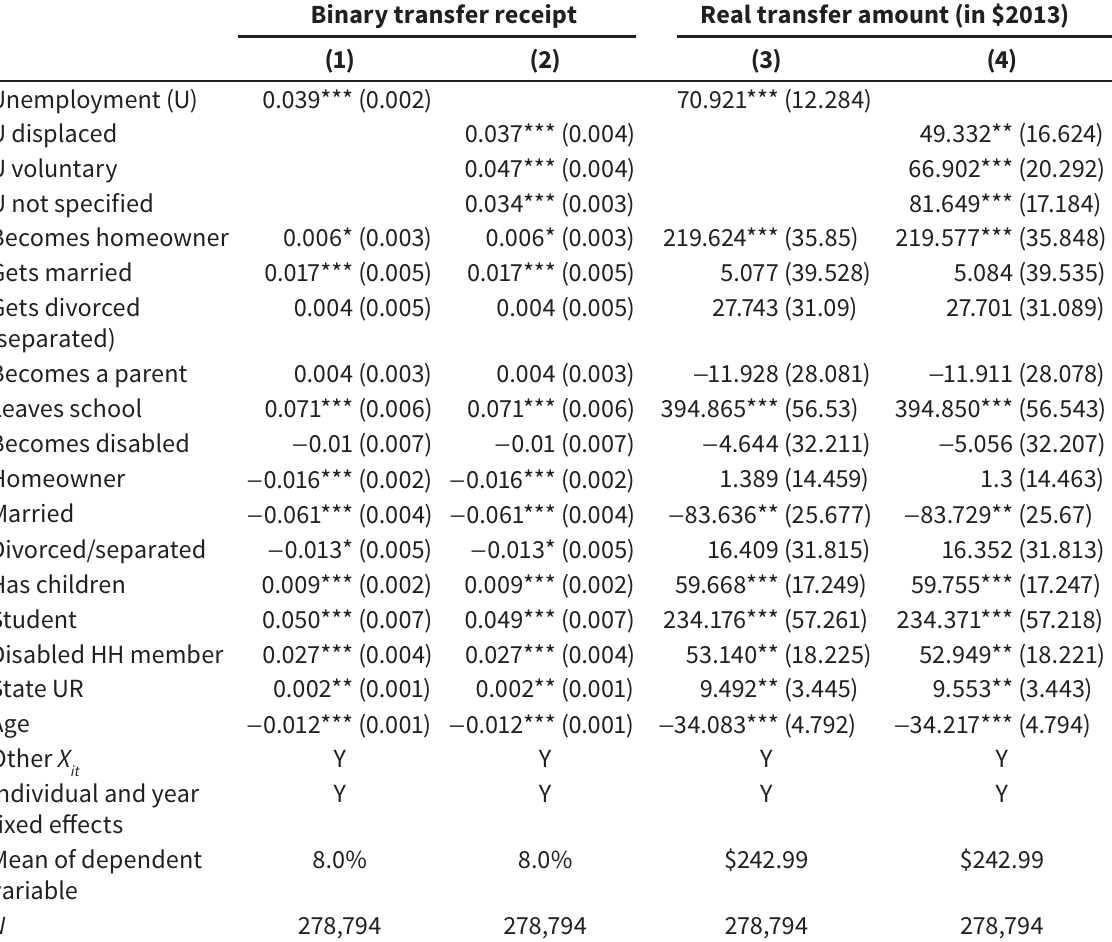
Coefficient estimates from regression of family transfer receipt on unemployment spell,